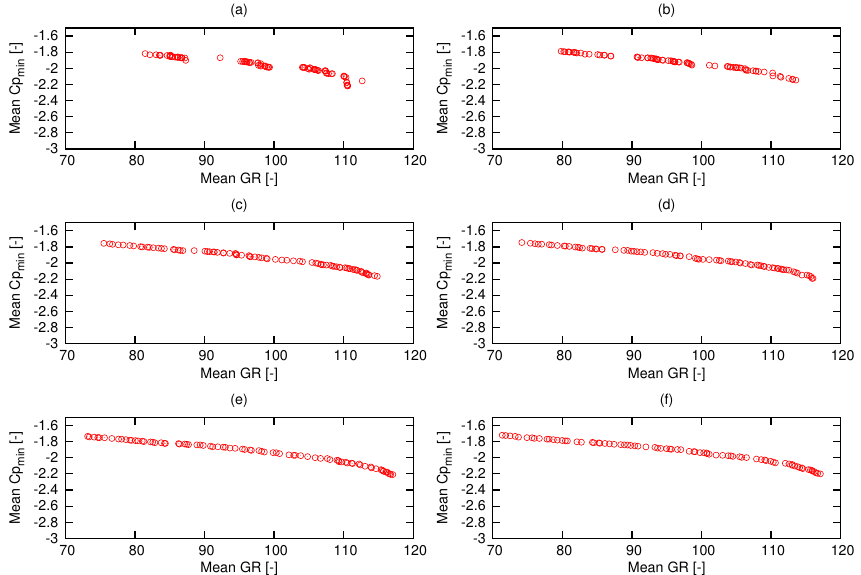
Figure 12. Graphs for the different generations in the first case of 2D optimization, where ( a ) represents the 5th, ( b ) represents the 10th, ( c ) represents the 15th, ( d ) represents the 20th, ( e ) represents the 25th, and ( f ) represents the 30th